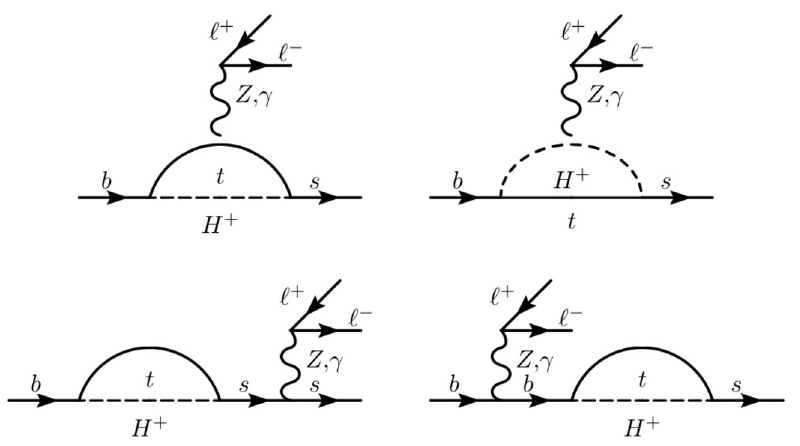
Figure 1 . Penguin diagrams for b → s‘ + ‘ − transitions.